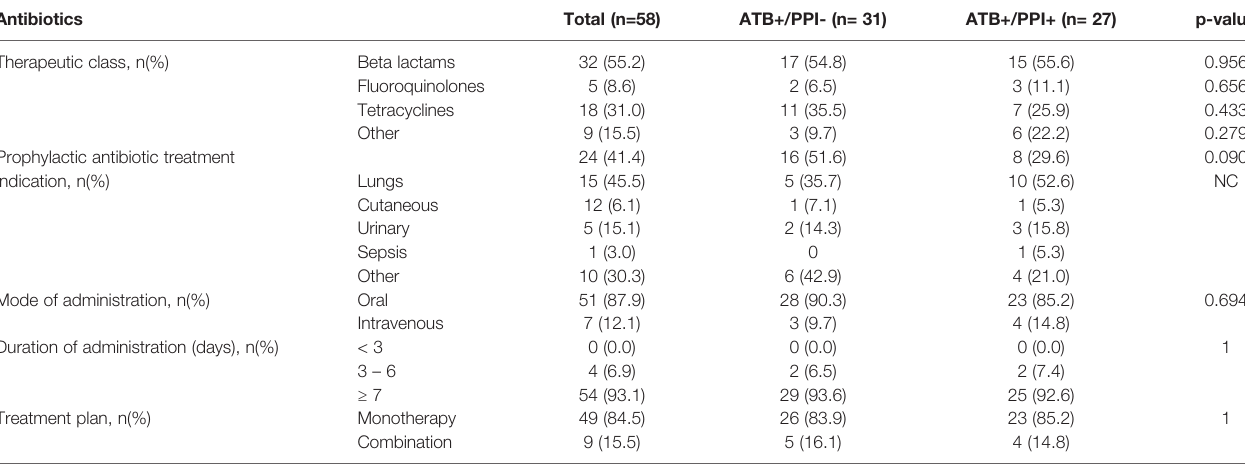
TABLE 2 | Characteristics of antibiotic therapy for the 58 patients with ATB and according to PPI use. Antibiotics